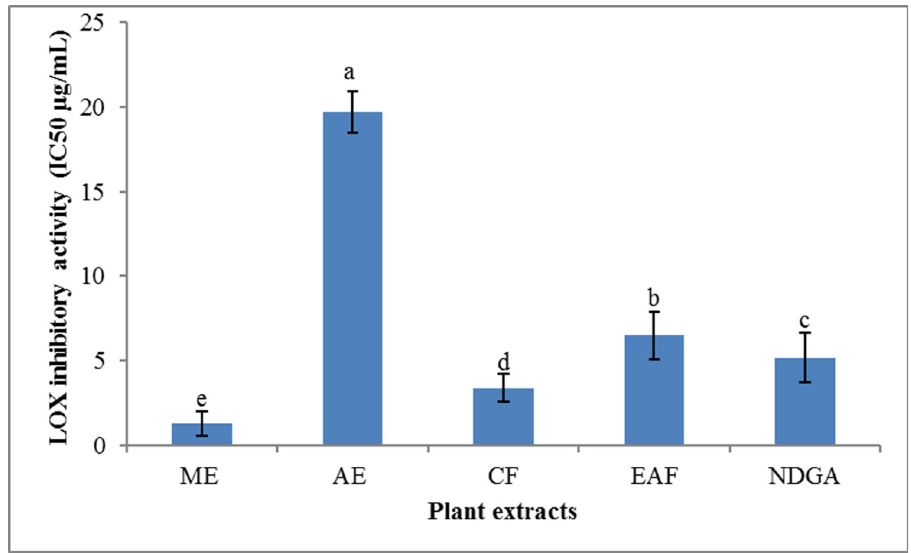
Fig 3. LOX inhibitory activities of J . mimosifolia methanol extract and soluble fractions expressed as IC 50 ( μ g/ mL). Data represent mean ± standard deviation (SD) of three biological replicates.